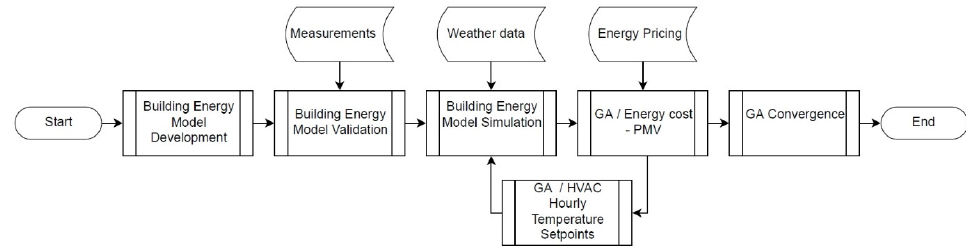
Figure 1. Genetic algorithm (GA)-based heating, ventilation, and air conditioning (HVAC) temperature set point optimization scheme.